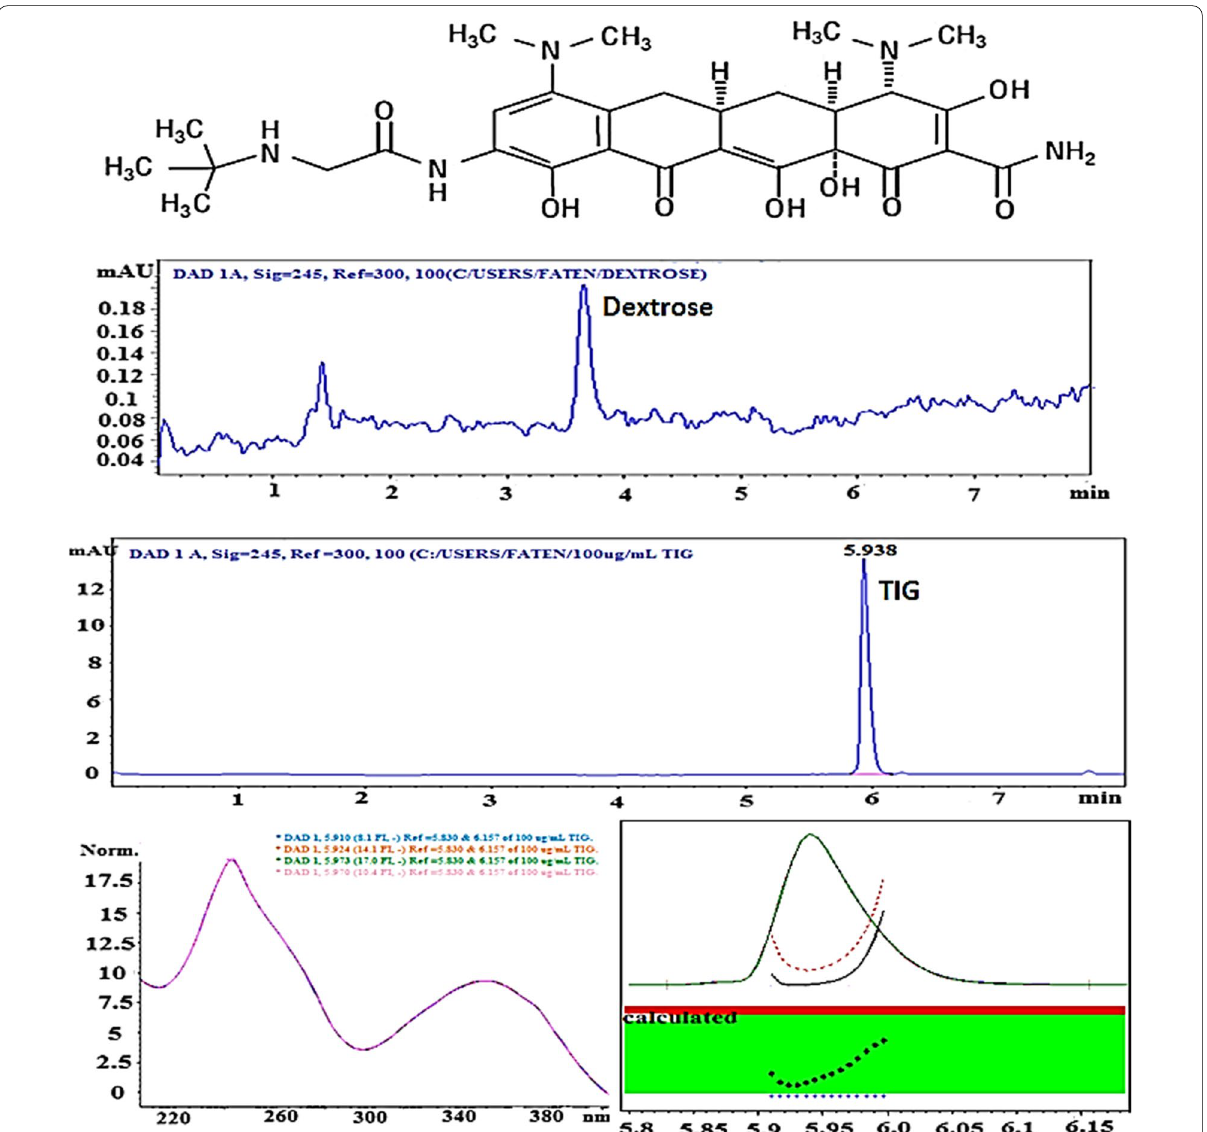
Fig. 1 ( a ) Chemical structure of TIG, ( b ) electropherogram of the 5% dextrose blank solution, ( c ) electropherogram of 100 µg/mL TIG in 5% dextrose injection solution using 50 µm internal diameter capillary of 56 cm effective length, ( d ) absorption spectra of TIG measured at 5 different time intervals across the peak and ( e ) its purity